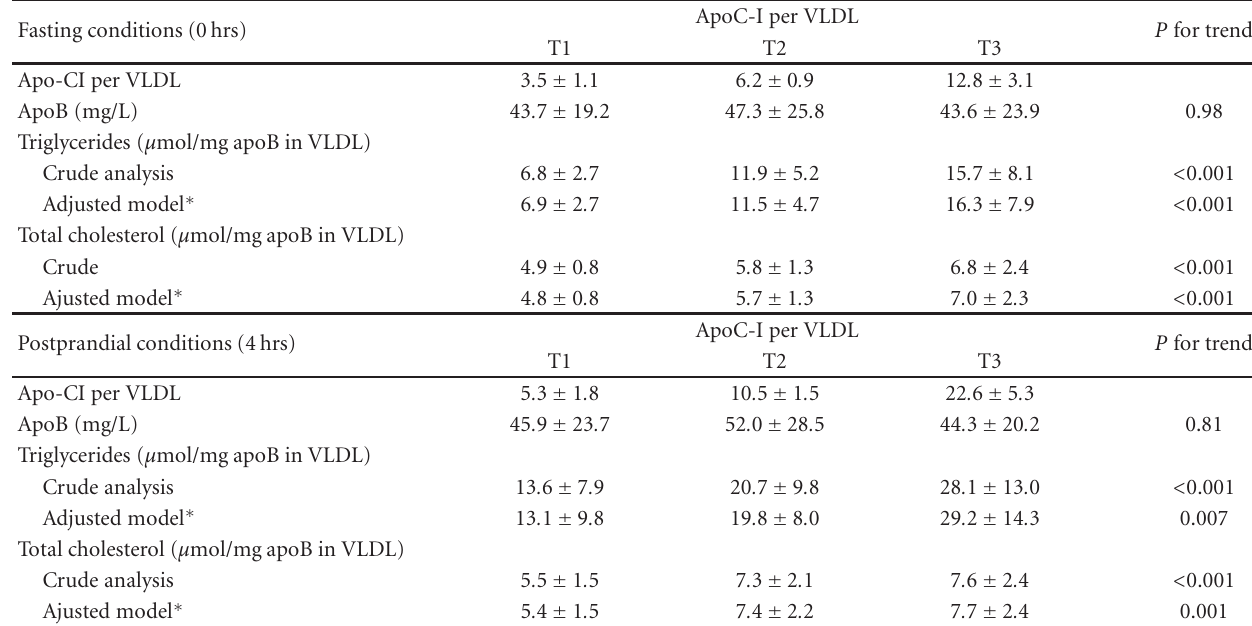
Table 2: Composition of VLDL particles. Composition of VLDL particles across tertiles of the number of apoC-I per VLDL particle isolated under fasting conditions and 4hrs after intake of a standard high-fat meal (Postprandial conditions) ( n = 81). Values are means ± 1 SD. Fasting conditions (0hrs)